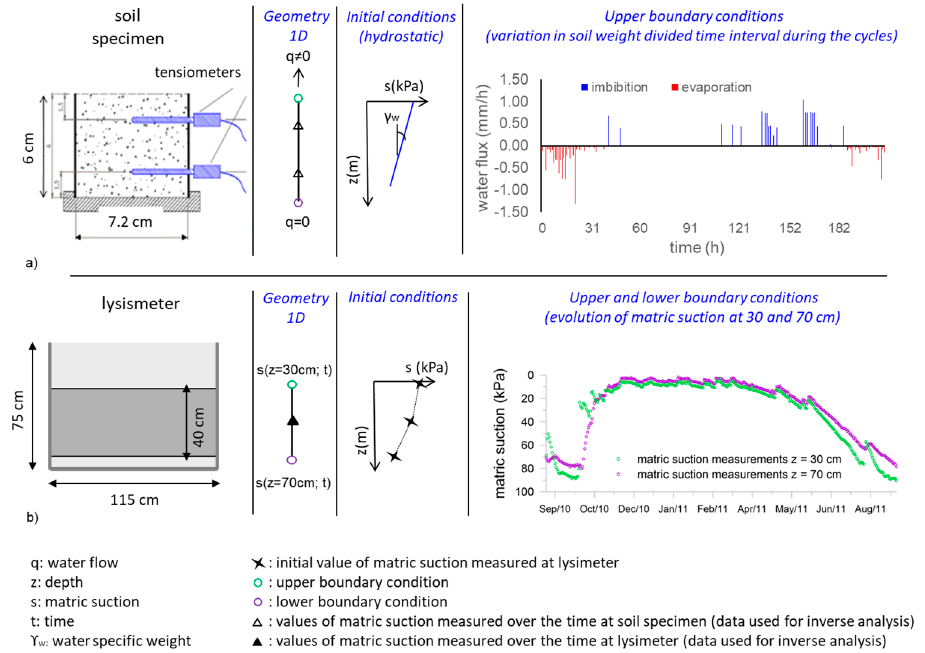
Figure 3. Geometry and initial and boundary conditions adopted in the inverse analyses: ( a ) soil specimen (Section 2.4.1); ( b ) lysimeters (Section 2.4.2).